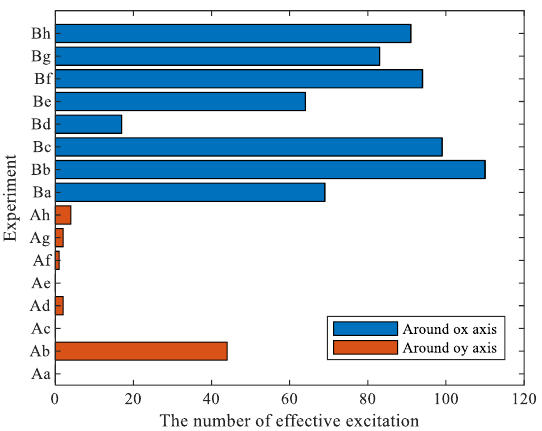
Figure 13. The number of effective excitations in the single-anchor line mooring mode. The total number of effective excitations for the buoy under different wave conditions was obtained by adding the numbers of effective excitations around the ox axis and oy axis, as shown in Figure 14. The numbers of effective excitations for Mooring Modes A and B both reached the peak under a regular wave with a height of 0.3 m and a period of 2.0 s. Under irregular waves, the number of effective excitations was not significantly influenced by the wave parameters. Overall, the number of effective excitations acting on the buoy in Mooring Mode B was obviously larger than in Mooring Mode A.